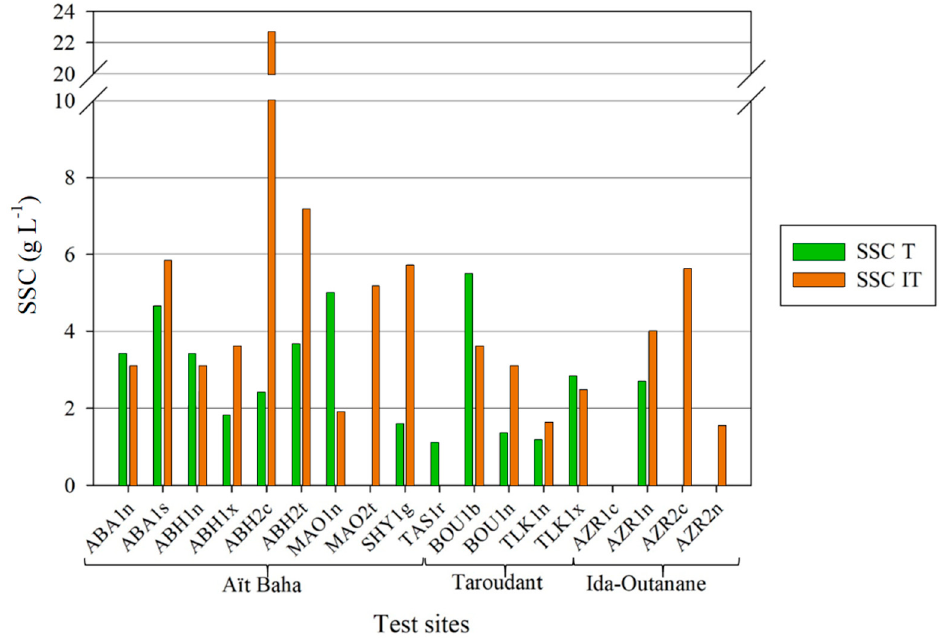
Figure 7. Suspended sediment concentration (SSC) for tree (T, black bars) and intertree areas (IT, grey bars) for each test site. Break between 10 and 20 g L − 1 because of test site ABH2c.